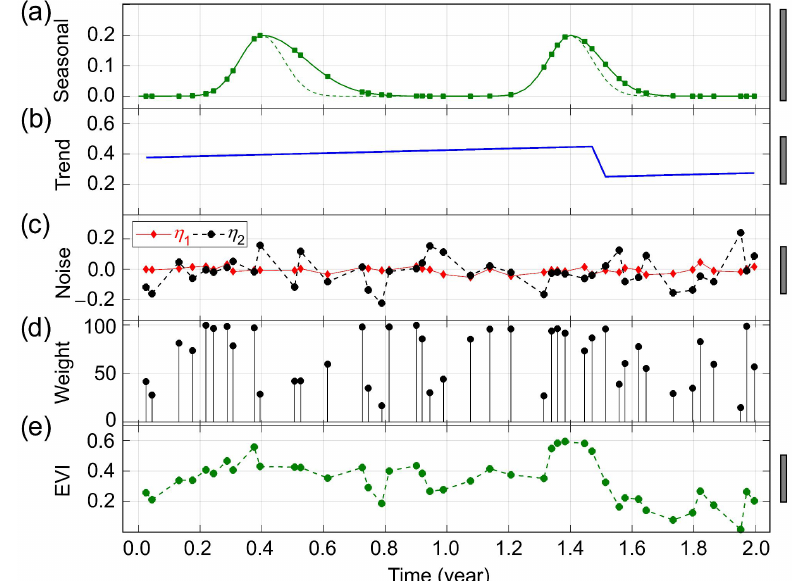
Figure 7. Simulation of an EVI time series for a two-year period, ( a ) the simulated seasonal component given by Equation (10) (the symmetric Gaussian function is shown by dashed lines for comparison), ( b ) the trend components with magnitude − 0.2 given in Table 2, ( c ) the noise η 1 with 0.1 level and noise η 2 with 0.4 level, ( d ) the weights defined by η 2 , and ( e ) the simulated EVI time series that is the sum of the seasonal, trend, and η 1 components minus the absolute value of η 2 . To help comparisons, the solid bars with the same data range are displayed on the right-hand side of the